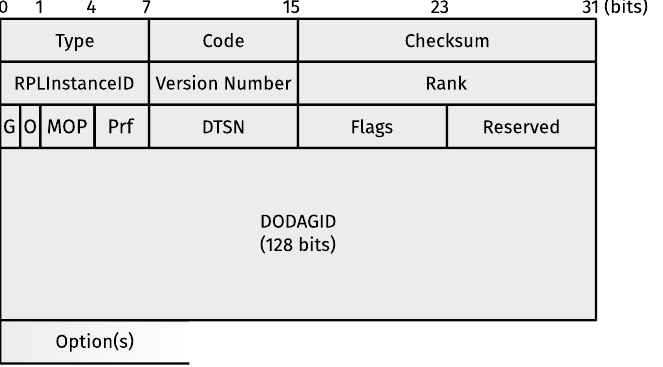
Figure 2. Format of an RPL Destination-Oriented Directed Acyclic Graph (DODAG) Information Object (DIO). Note that a DIO is an Internet Control Message Protocol (ICMP) Version 6